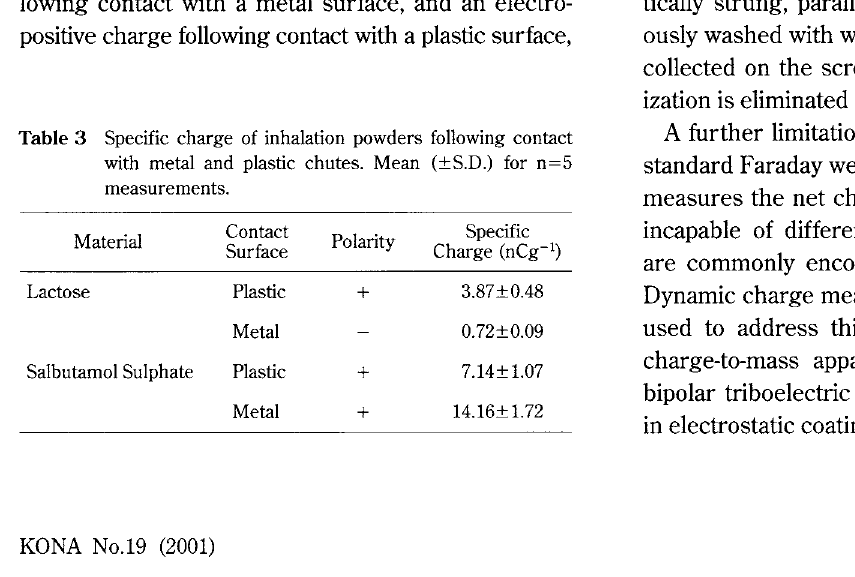
Table 3 Specific charge of inhalation powders following contact with metal and plastic chutes. Mean (±S.D.) for n=5